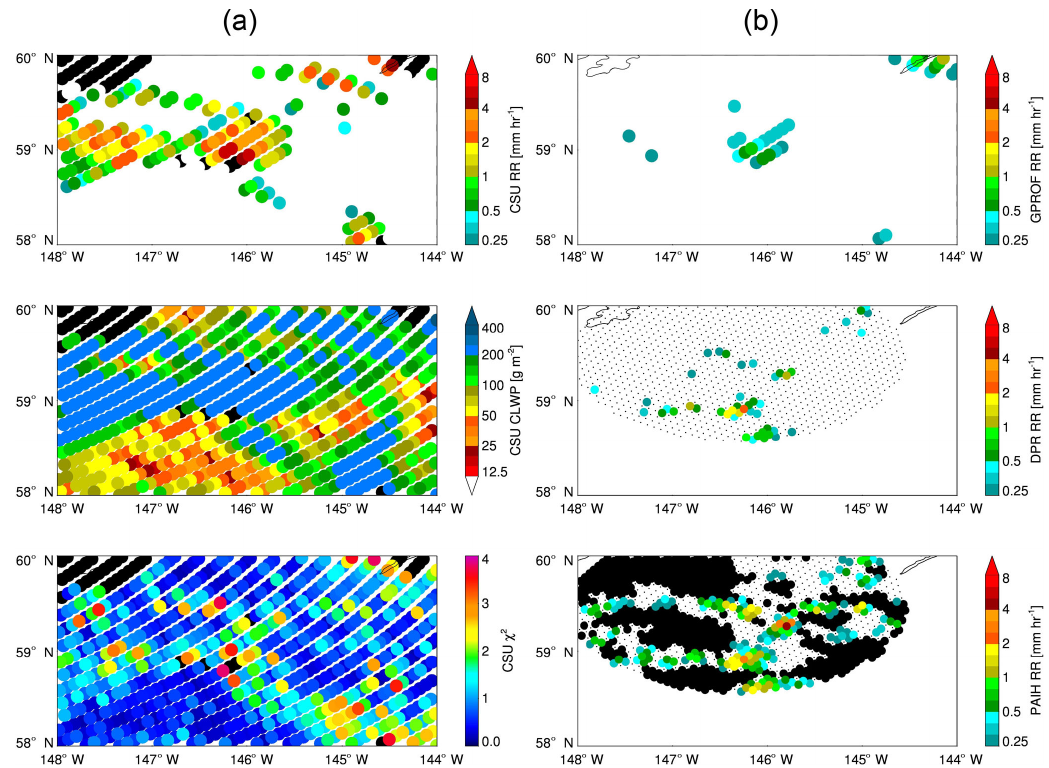
Figure 9. Middleton Island (PAIH) radar compared with GPM products and CSU 1DVAR retrievals from 12 July 2015. Panel (a) contains CSU 1DVAR retrievals of rain rate and cloud liquid water path, and quality of fit ( χ 2 ). Panel (b) contains rain rates from GPROF, DPR, and the ground radar. Colour conventions follow those of Fig.